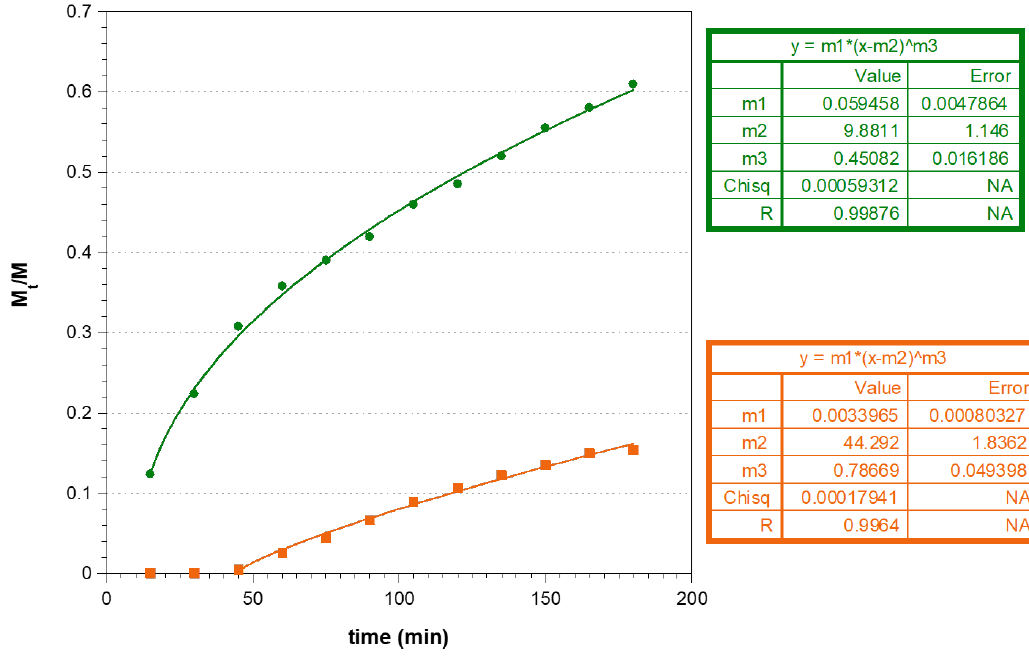
Figure 6. Plot of cumulative amount of MTR ( (cid:8) ) and CUR ( (cid:4) ) released from Tablet A and their fit with the modified Korsmeyer–Peppas model of MTR ( -- ) and CUR ( -- ). Different physico-chemical phenomena are involved in the matrix tablet release mechanism.